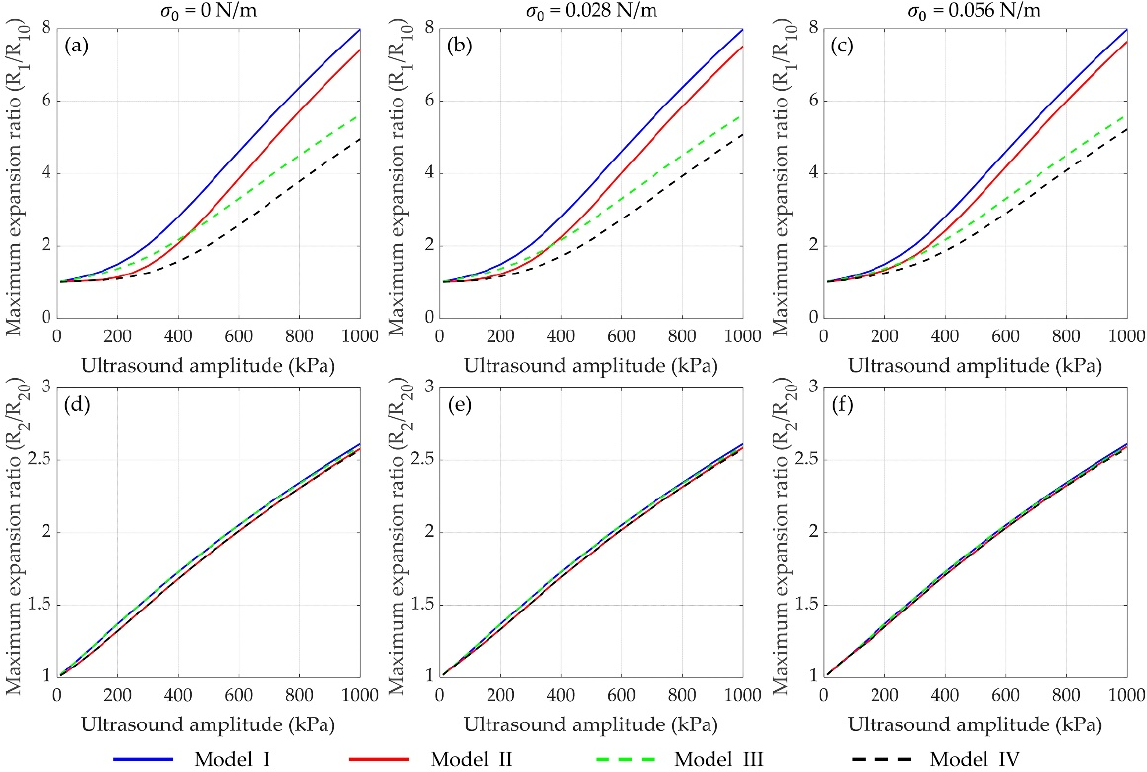
Figure 3. Maximum expansion ratios of ( a – c ) the small bubble ( R 1 ) and ( d – f ) the large bubble ( R 2 ) as function of ultrasound amplitude with the same conditions as Figure 2.